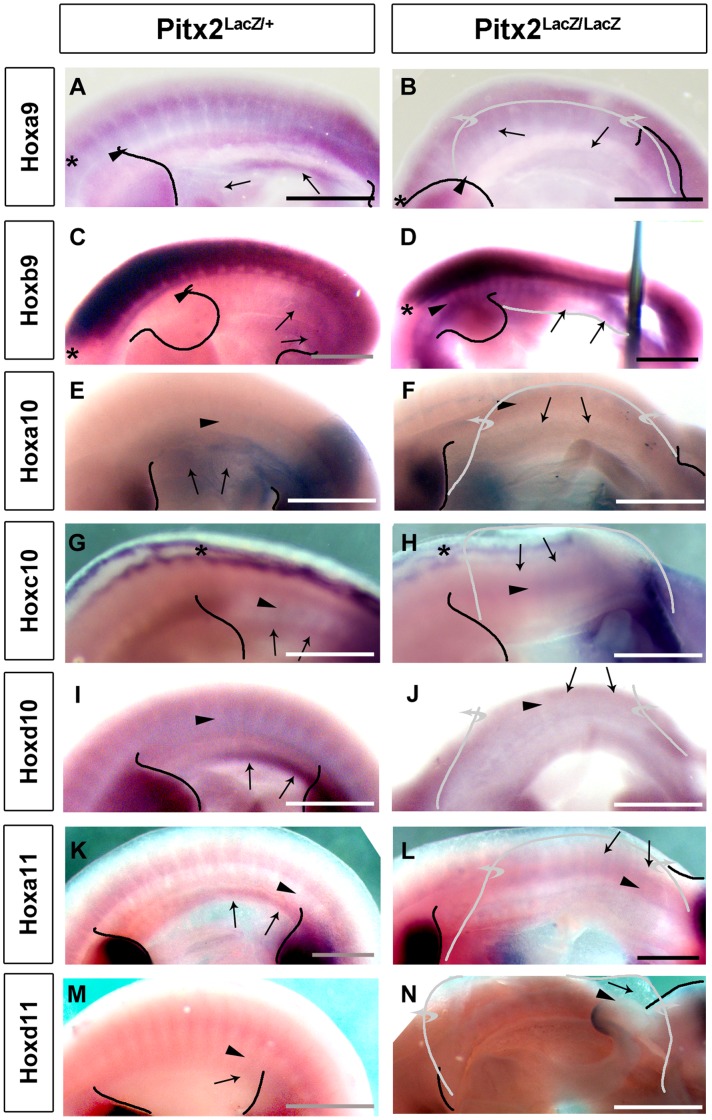
Loss of Abdominal Hox 9-11 Expression Domains in Pitx2 Mutants.
In situ hybridization with indicated Hox probes on heterozygote (A,
C,
E,
G,
I,
K,
M) and mutant (B,
D,
F,
H,
J,
L,
N) E10.5 mice. Left sides are shown, with head to the left. Limb buds are traced in black and the upturned body walls (swooshes) of mutants are traced in grey. The anterior expression boundary in the neuroectoderm/DRG is indicated by an asterisk, except in panels G and H where the asterisk indicates equivalent axial levels at which expression in the dorsal midline converges. Black arrowheads indicate the approximate expected anterior expression boundary in the sclerotome compartment of the paraxial mesoderm. Based on phenotypic considerations, this boundary lies just behind the forelimb, just behind the ribs, and just prior to the hindlimbs for Hox 9, 10, and 11 paralogs, respectively. Black arrows indicate zones of expression in heterozygoetes and equivalent positions in the upturned body walls of mutants, or in the intermediate mesoderm where expression is not observed. Note that expression of Hoxd11 in the caecum is still present in mutants (N), but cannot be seen in heterozygotes (M) because it is inside the intact body wall. All embryos are positioned with head to the left. Scale bar, 1 mm.